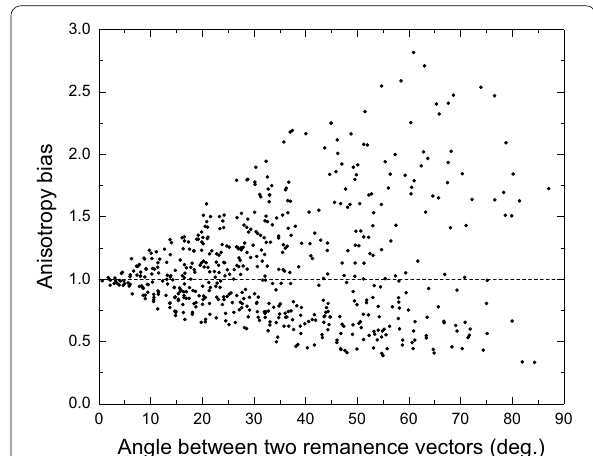
Fig. 13 Anisotropy bias calculated from the typical anisotropy tensor of plagioclase samples as a function of angle between two remanence vectors (here assumed to be NRM and ARM0). An anisotropy bias larger than 1 indicates that the paleointensity is overestimated, and vice